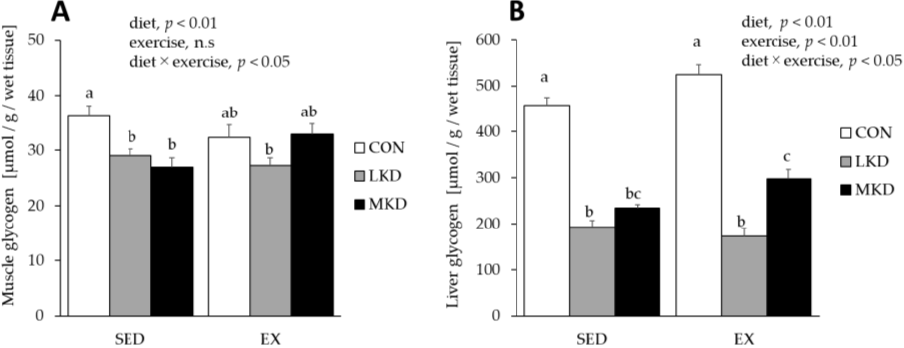
Figure 6. Glycogen levels in the triceps muscle tissue ( A ) and liver tissue ( B ). Two-way ANOVA was performed, followed by Tukey–Kramer multiple-comparison tests. Means of treatments labeled with the same letter are not significantly different from each other. Values are means ± SEM, n = 7. A significant interaction between diet and endurance exercise training was observed for liver glycogen concentration. In both the SED and EX groups, liver glycogen concentrations in the LKD and MKD groups were significantly lower than those in the CON group. However, liver glycogen concentration was significantly higher in the EX-MKD group than the EX-LKD